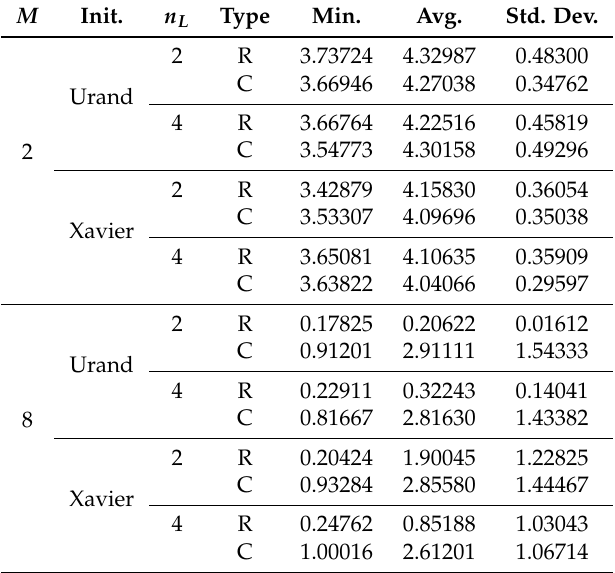
Table 2. E ( Q NN ) analysis for h = sigmoid ( N run =